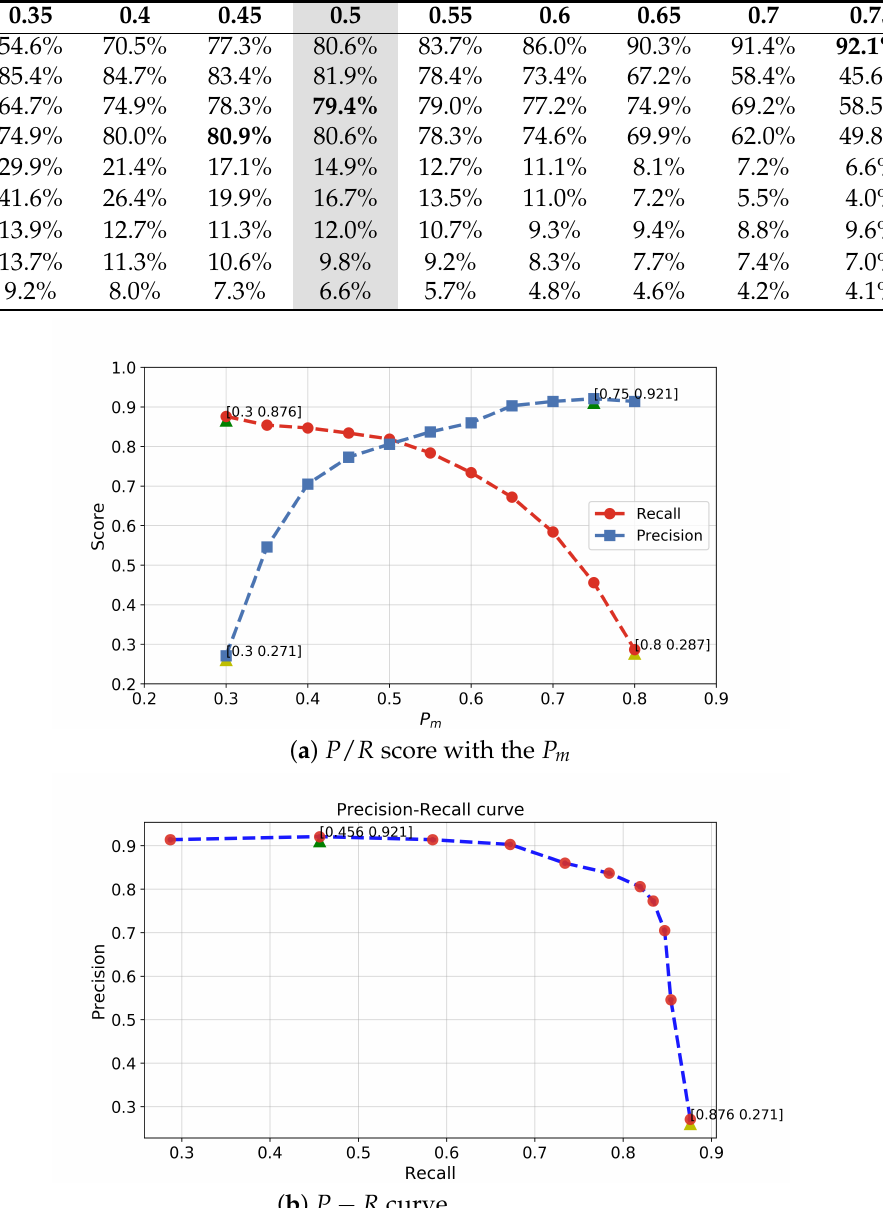
Table 2. Crater edge extraction results of test sets in terms of various match thresholds P m .